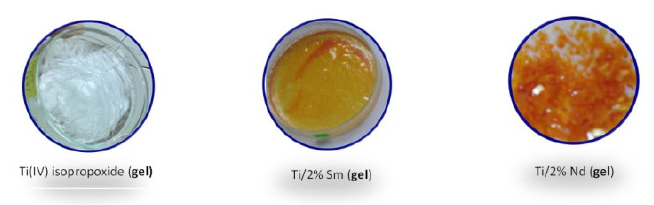
Figure 1. Images of the as-prepared gels.